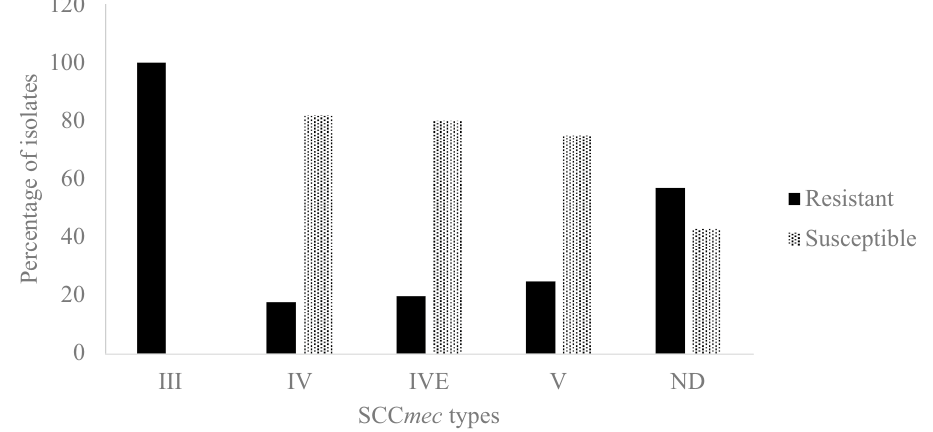
Figure 3. Distribution of moxifloxacin resistance among the different SCC mec types detected in the isolate collection. All SCC mec III isolates were moxifloxacin resistant whereas SCC mec IV, IVE and V isolates were mostly moxifloxacin susceptible.